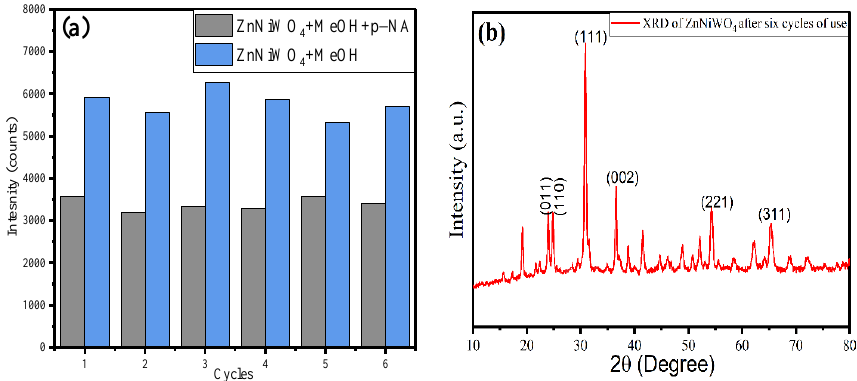
Figure 13. ( a ) Reusability test for ZnNiWO 4 towards p-NA sensing. ( b ) XRD of ZnNiWO 4 after six cycles of